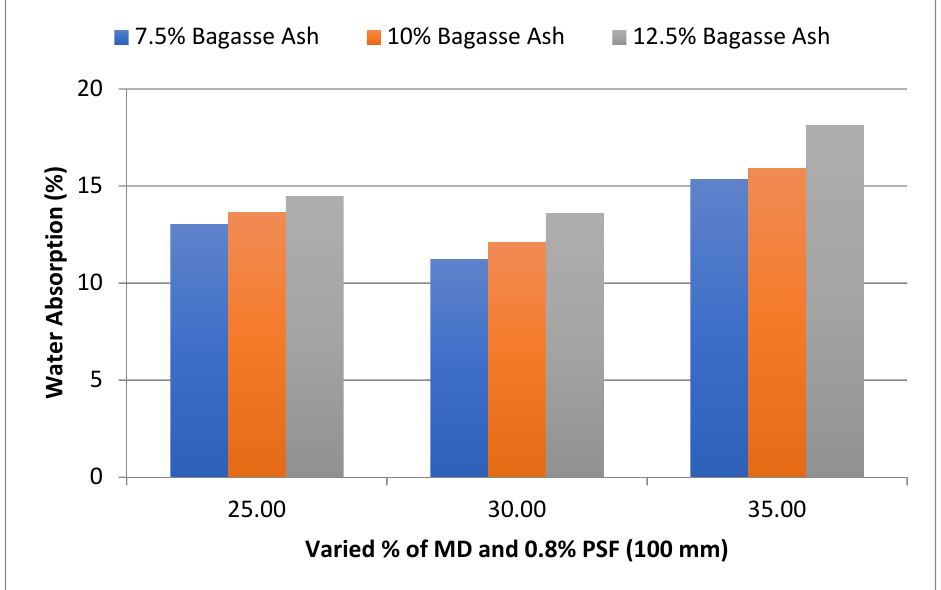
Figure 5. Effect of MD and BA on water absorption of block reinforced with 0.8% PS fiber (100 mm).